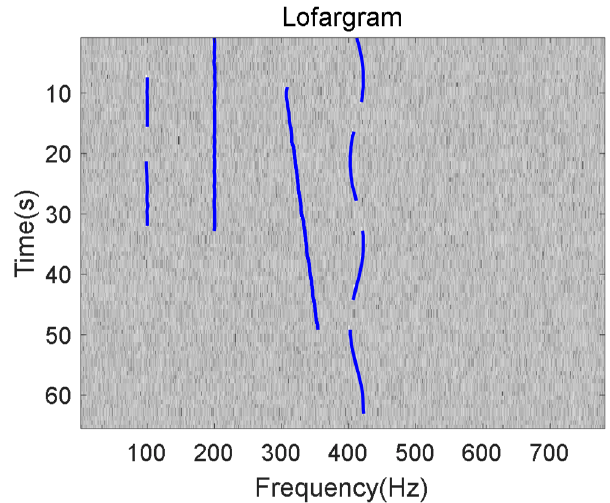
Figure 15. Final frequency line tracking results of proposed method.